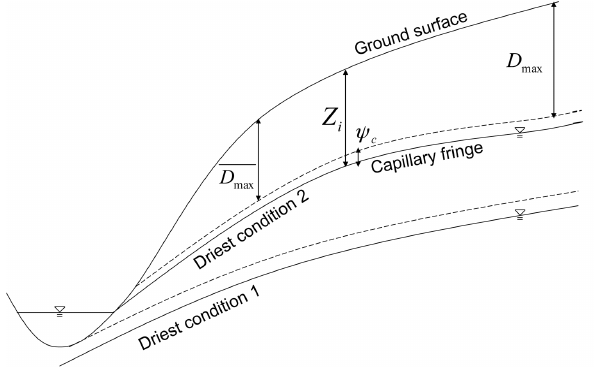
Fig. 1. Schematic hillslope section. D max is the average storage deficit under the driest condition, D max is the largest storage deficit under the driest condition, Z i is the water table depth, and 9 c the height of the capillary